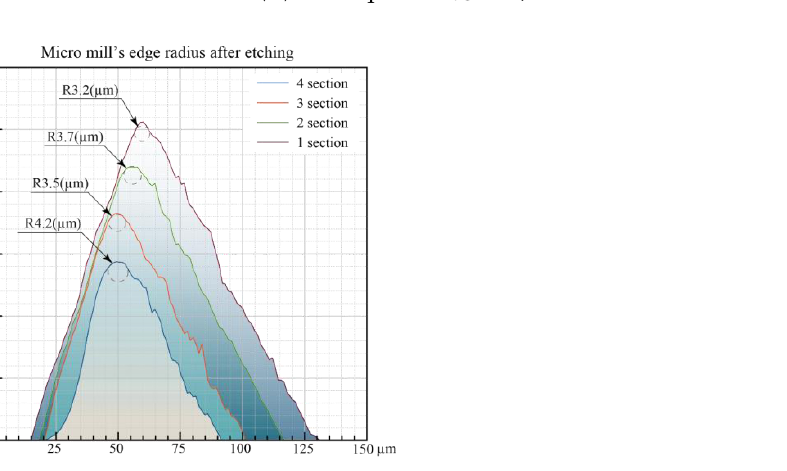
end at 7 mm and distanced from each other at 0.05 mm. at 7 mm and distanced from each other at 0.05